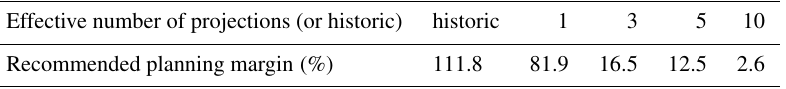
Table 2. Recommended planning margin when using the historic record versus differing numbers of effective projections for estimating the initial parameter space.